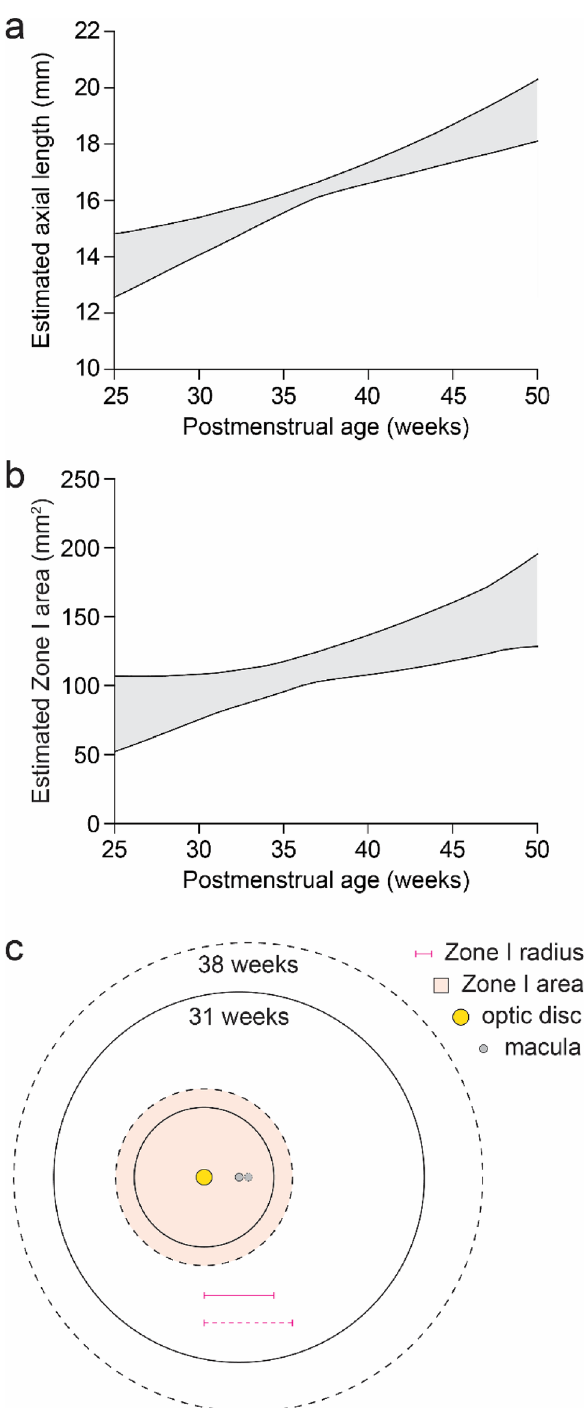
Figure 4. Postmenstrual age can approximate axial length to model zone area. ( a ) Range of estimated AL values at different PMAs. ( b ) Range of estimated ICROP Zone I areas at different PMAs. ( c ) Depiction of a 60% increase in retina and Zone I areas from PMA 31 (solid lines) to 38 (dashed lines) weeks based on model